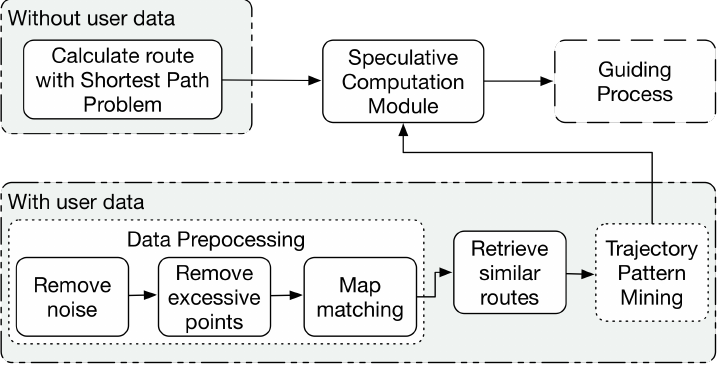
Figure 7. Process for generating adapted routes.